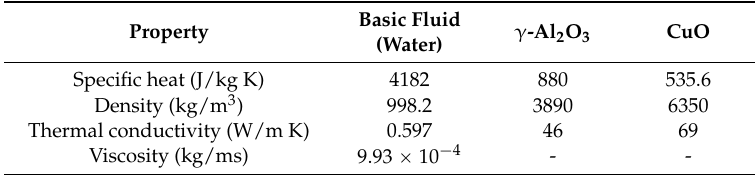
Table 1. Thermophysical properties of base fluid and nanoparticles at 298